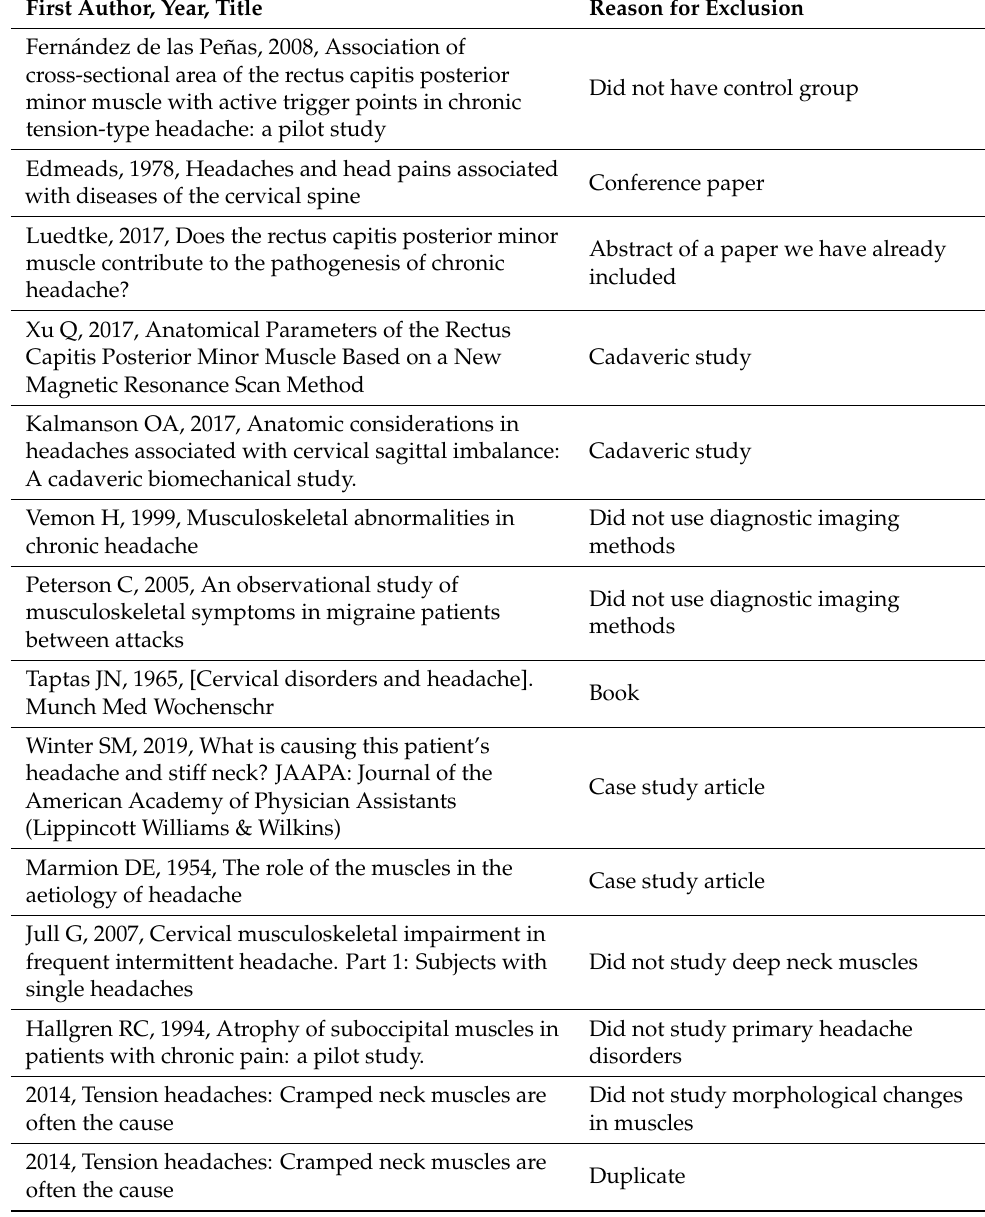
Table A3. Reason for exclusion. This table shows the reasons for exclusion of the studies discarded in the full-text screening